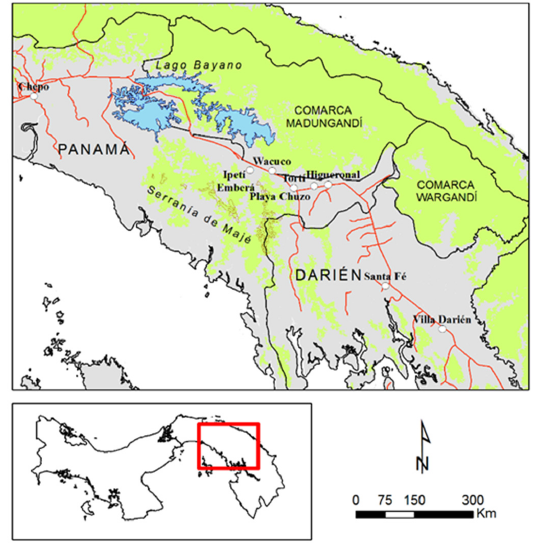
Figure 1. The Bayano ‐ Darién Region. Note: forest cover is for 2007.